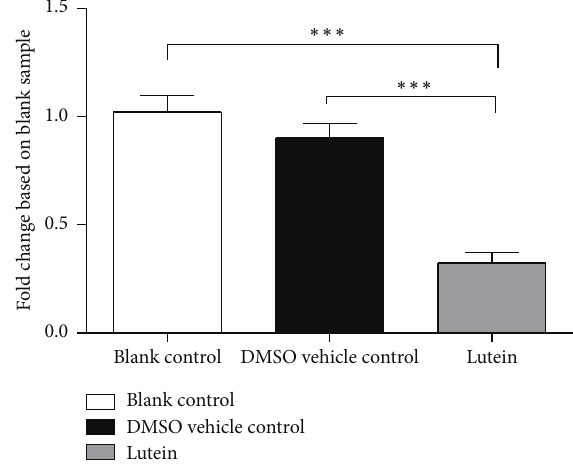
Figure 3: Factor D mRNA expression in 20-day differentiated SGBS adipocytes incubated for 48 h with culture medium (blank control), 0.5% DMSO (DMSO vehicle control), or lutein (50 𝜇 g/mL) in the presence of 0.5% DMSO (lutein). Bars represent fold change of FD mRNA expression compared to blank control ( ∗∗∗ 𝑝 < 0.0001